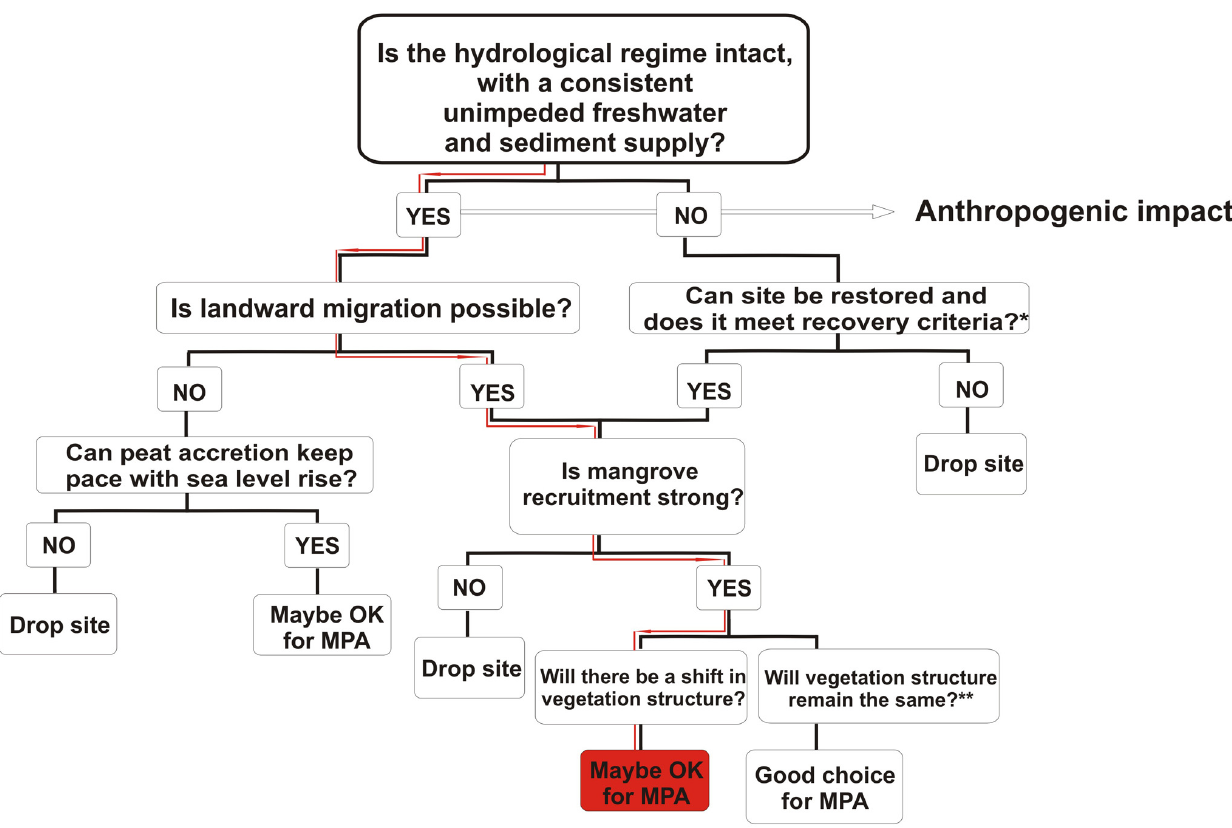
Fig. 5. Decision tree to aid resilient site selection for mangroves according to McLeod and Salm (2006). This three can be applied once candidate sites of high biodiversity have been selected using biological criteria, for instance *, factors that indicate strong recovery potential (see Appendix Table C1). This decision tree was adjusted (**) to implement the possibility of a shift in vegetation structure. MPA=marine protected